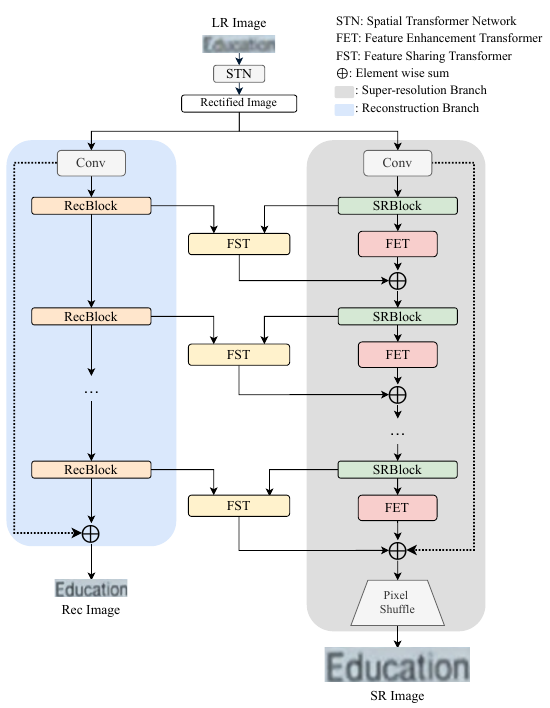
Figure 2. The overall architecture of our proposed MTSR Network for STISR. FET and FSR stand for Feature Enhancement Transformer and Feature Sharing Transformer,